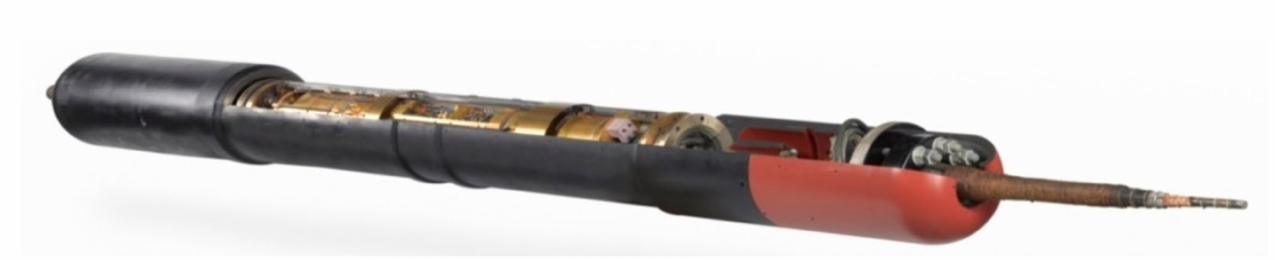
Figure 15. All element parts of the first-generation sectioned submerged repeater for TAT-1 the first transatlantic telephone cable [1].